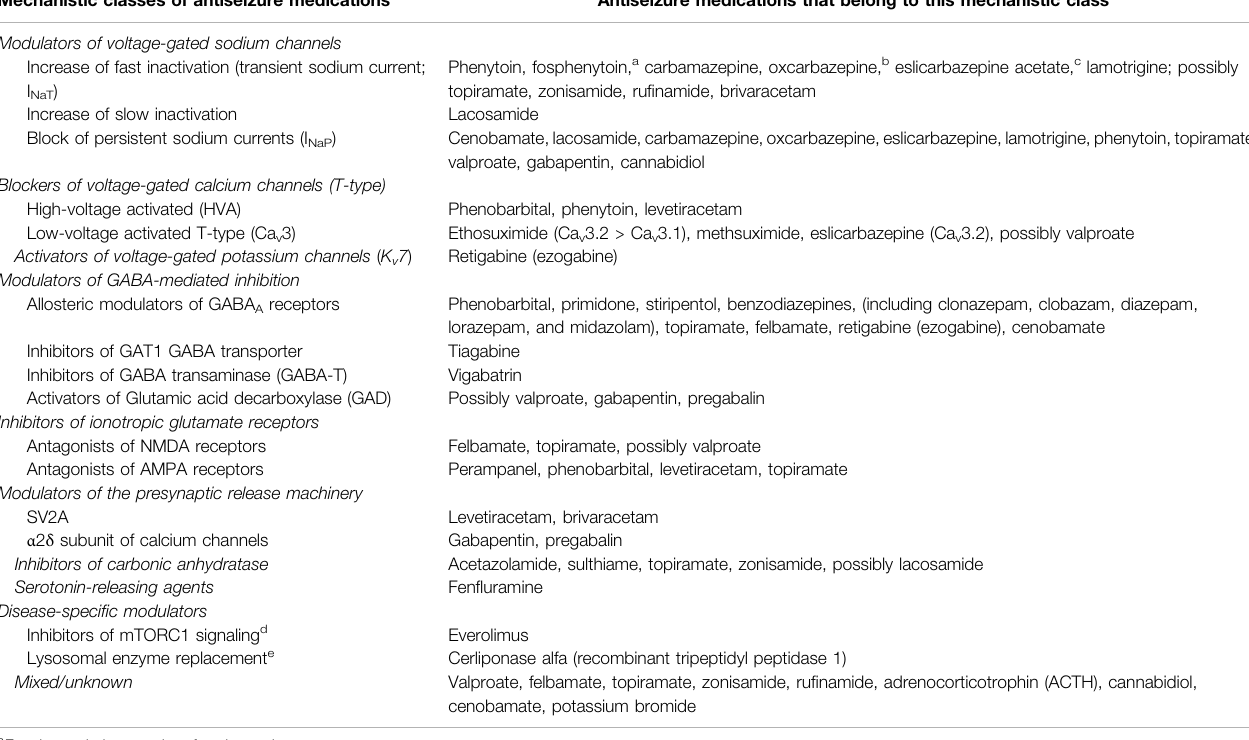
TABLE 2 | Perceived molecular targets of clinically used antiseizure medications. Adapted from Rogawski and Löscher (2004), Rogawski et al. (2016), Sills and Rogawski (2020), and Löscher and Klein (2021a). Mechanistic classes of antiseizure medications Antiseizure medications that belong to this mechanistic class Modulators of voltage-gated sodium channels Increase of fast inactivation (transient sodium